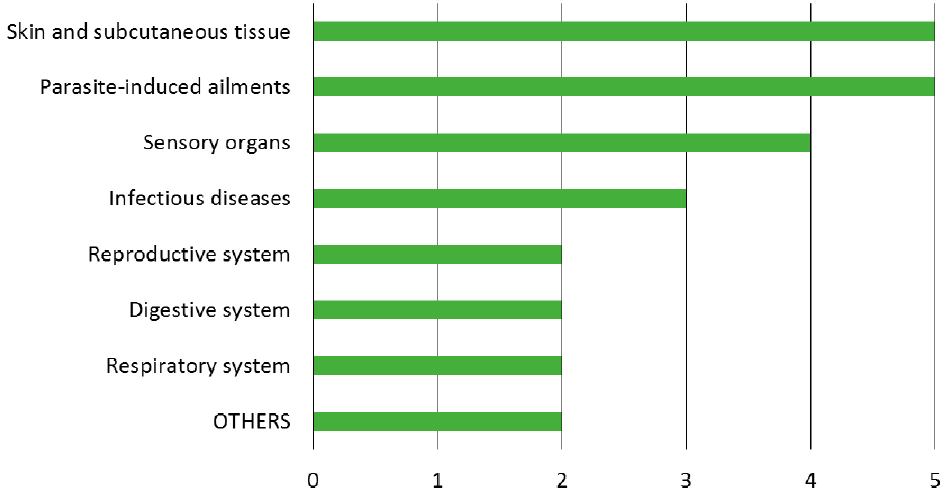
Figure 2. Number of empirical remedies documented used per disease category.